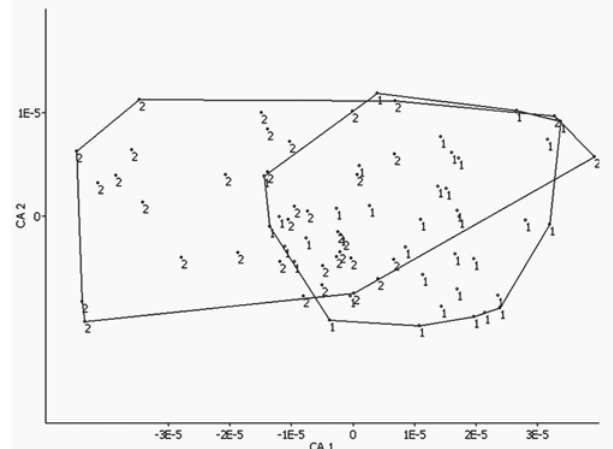
Fig. 4. Projection of first and second canonical variables (CV) 1 and 2 taken from a discriminant analysis of the size-inde- pendent residuals of morphometric data between two popu- lations of Astyanax altiparanae from the upper rio Tibagi (1, n=36), and upper rio Iguaçu (2,